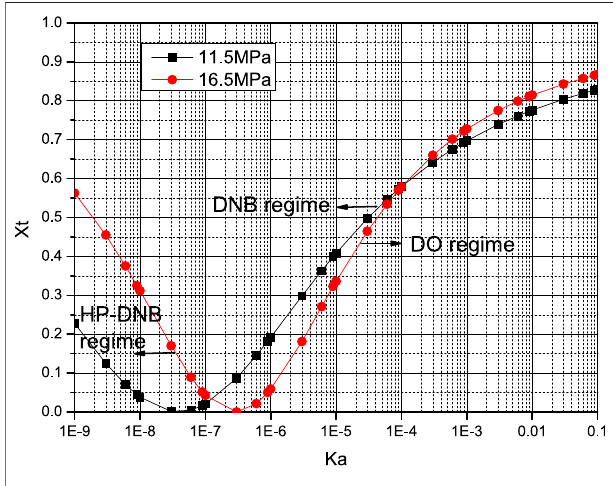
FIGURE 2 | Dimensionless rod bundle CHF-regime map (Liu et al., 2021a).